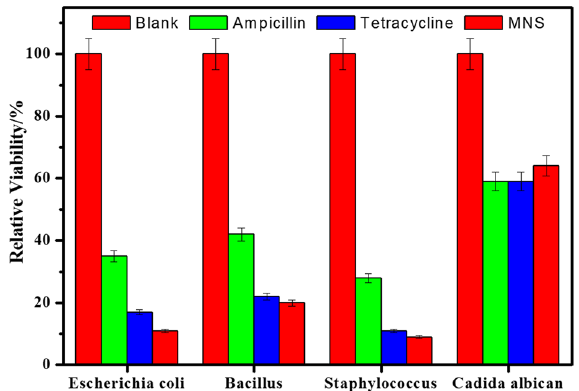
Figure 2. Relative viability diagram after 24 h of incubation with various antimicrobial agents against different types of microorganisms.